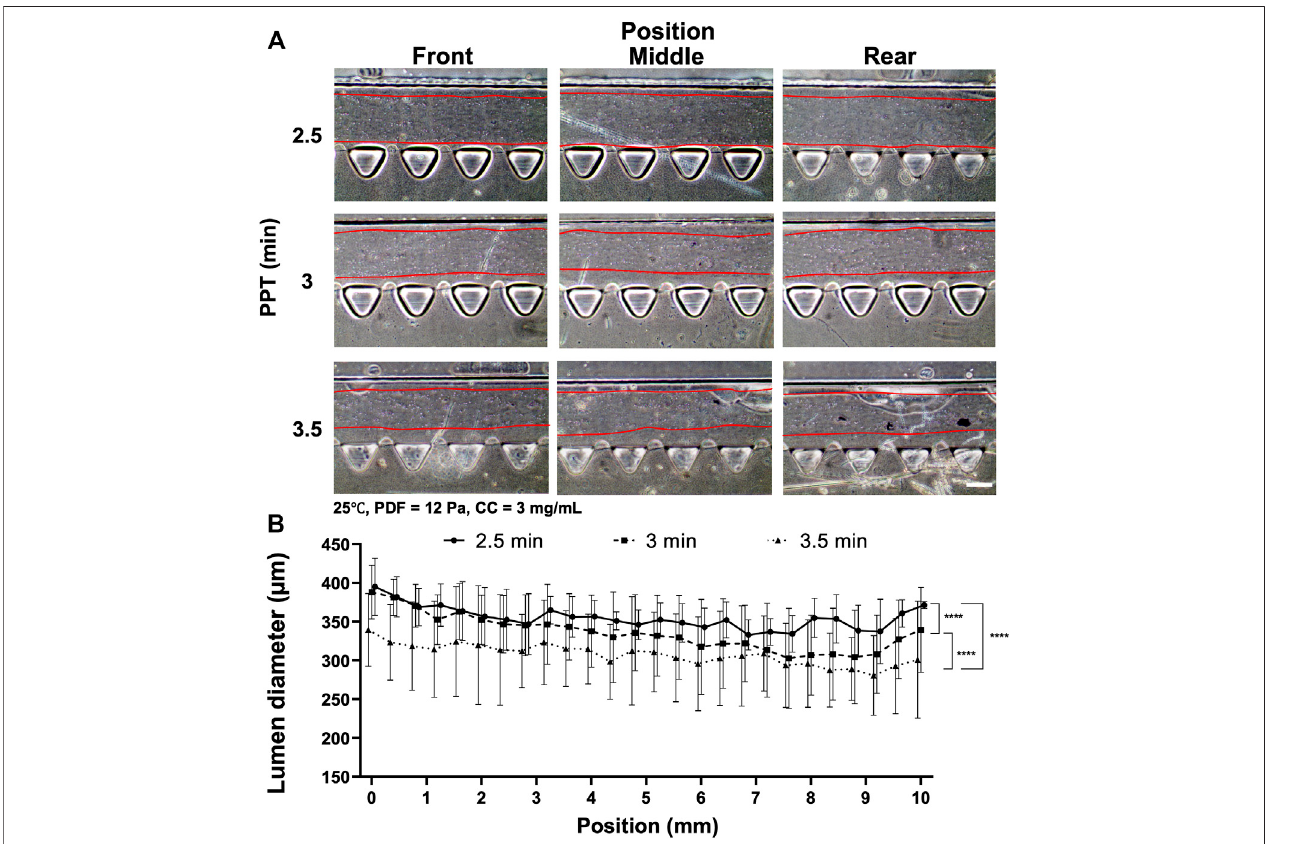
FIGURE3| ComparisonofthecollagenlumenformedatdifferentPPTs,i.e.,2.5,3,and3.5 min,wherethetemperaturewassetat25 ° C,PDFat90 – 50 µl,andCC at 3 mg ml − 1 . (A) Morphologyofthecollagenlumen formedat differentlocationsofthemediachannelatdifferentPPTs. (B) Quanti fi cationoftheaveragecollagenlumen diameter at different locations in the media channel polymerized at a PPT of 2.5, 3, or 3.5 min. Scale bar: 200